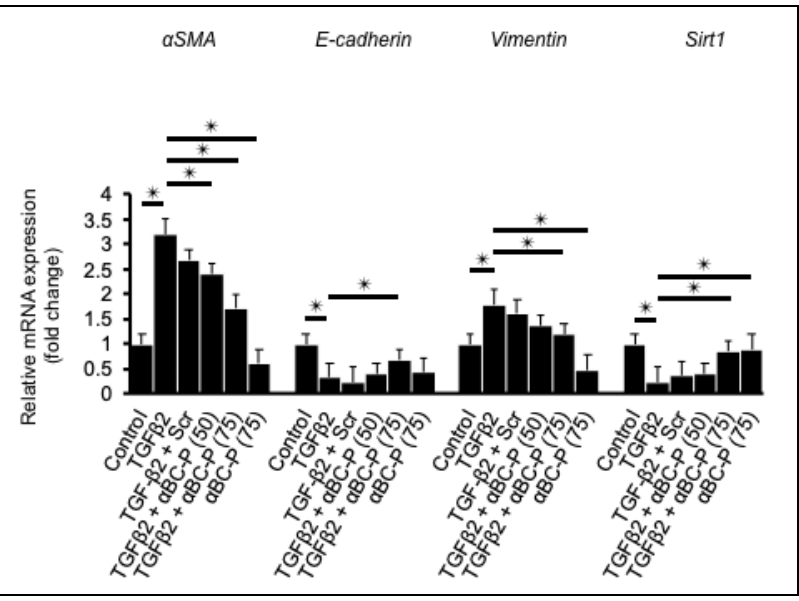
Figure 1. Attenuation of EMT in TGFβ2–induced hRPE by αBC -P. Sub-confluent fetal hRPE cells were treated with TGFβ2 (10 ng /mL) alone or/with Scr. (75 μg /mL) or/with αBC - P (50 and 75 μg /mL) or αBC - P (75 μg /mL) alone for 48 h. αSMA and Vimentin mRNA increased significantly with TGFβ2 treatment, and αBC -P treatment significantly decreased their levels. E-cadherin and Sirt1 mRNA treatment, and α BC-P treatment significantly decreased their levels. E-cadherin and Sirt1 mRNA decreased significantly with EMT, and αBC -P treatment significantly increased their levels. Scr: decreased significantly with EMT, and α BC-P treatment significantly increased their levels. Scr: S crambled peptide, αBC - P: αB crystallin -chaperone peptide. Values are means ± SEM. * p < 0.05. n = 5. Scrambled peptide, α BC-P: α B crystallin-chaperone peptide. Values are means ± SEM. * p < 0.05. n =